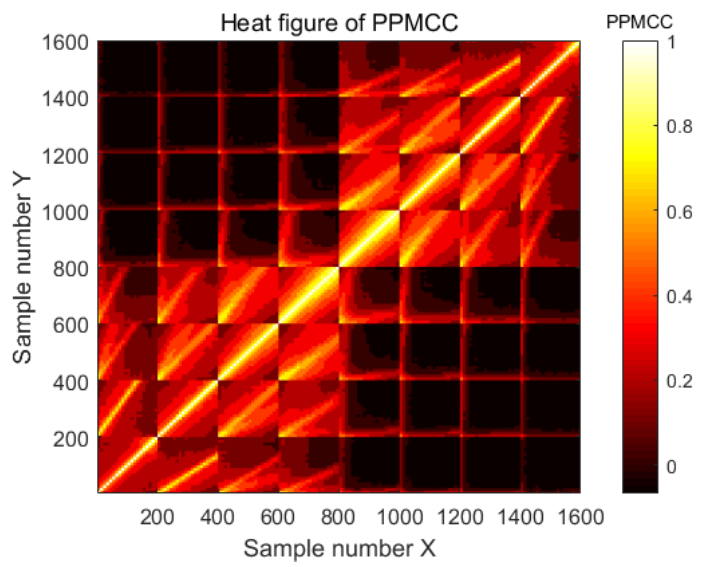
Figure 5. The Pearson product-moment correlation coefficient (PPMCC) heat map of fiber Brag grating (FBG) sensors.